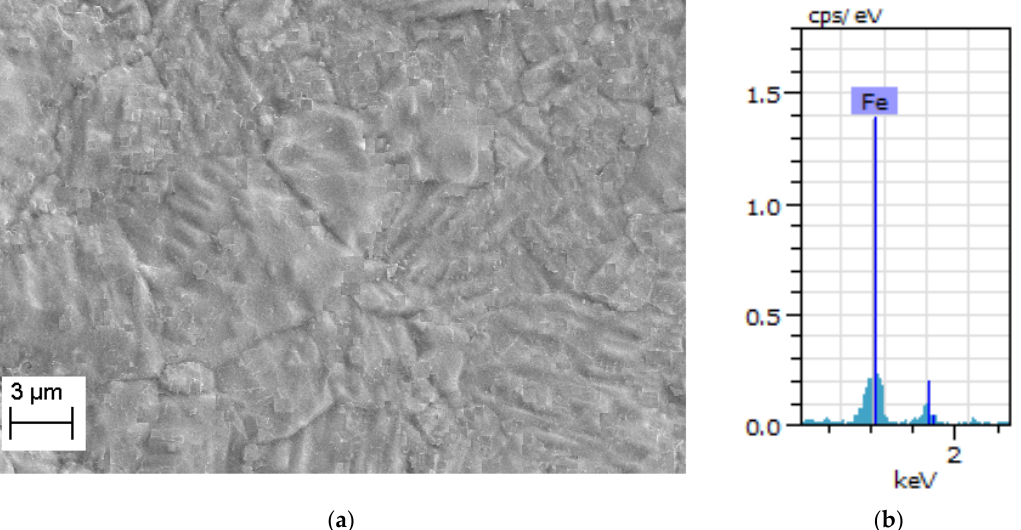
Figure 6. ( a ) SEM image of argon annealed pure iron. ( b ) EDS analysis of argon annealed pure iron.